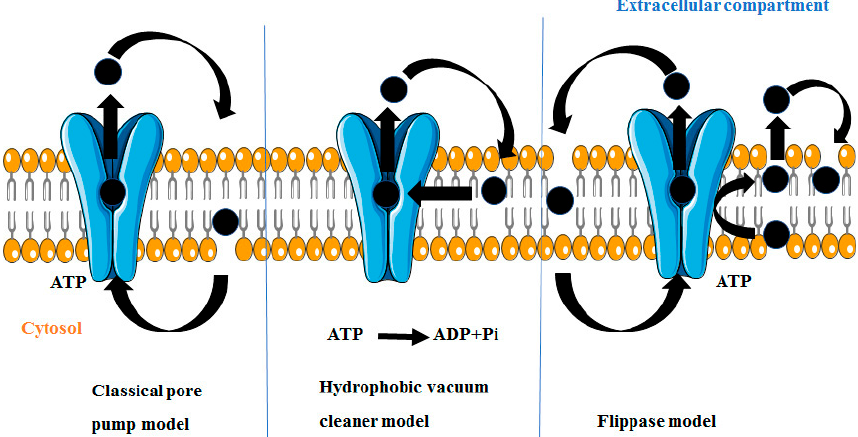
Figure 5. Different functional models of P-gp induced MDR [46–48].